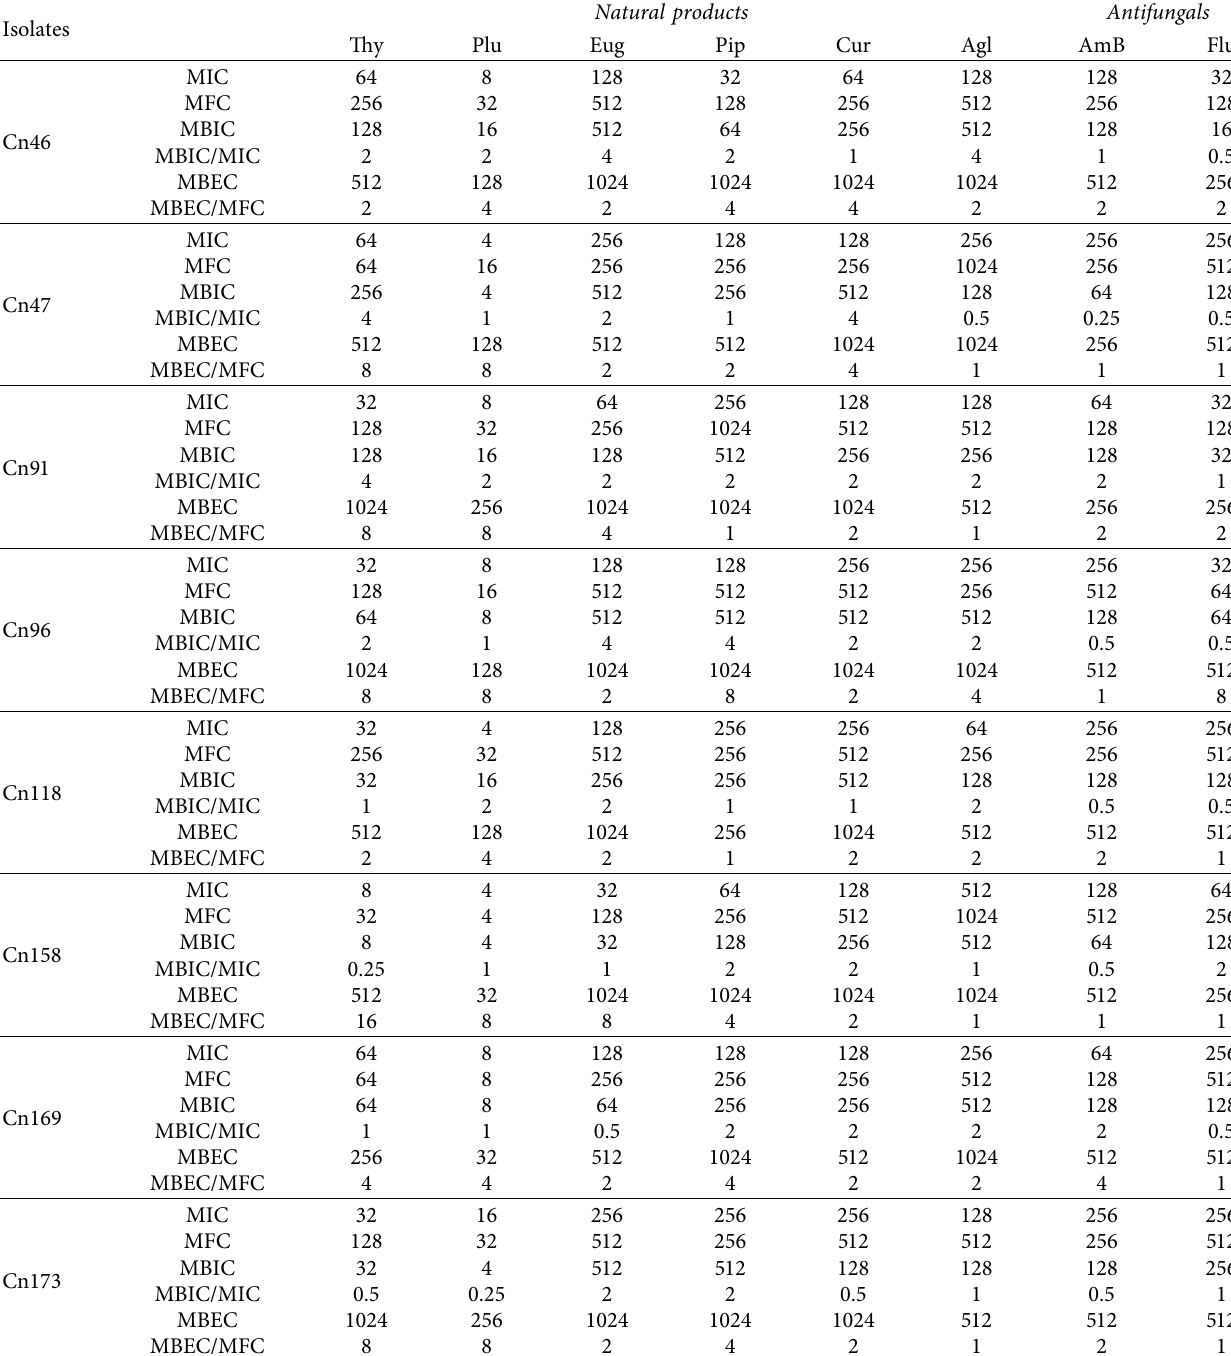
Table 3: Antifungal and antibioflm activities of natural products against C. neoformans isolates. Natural products Isolates